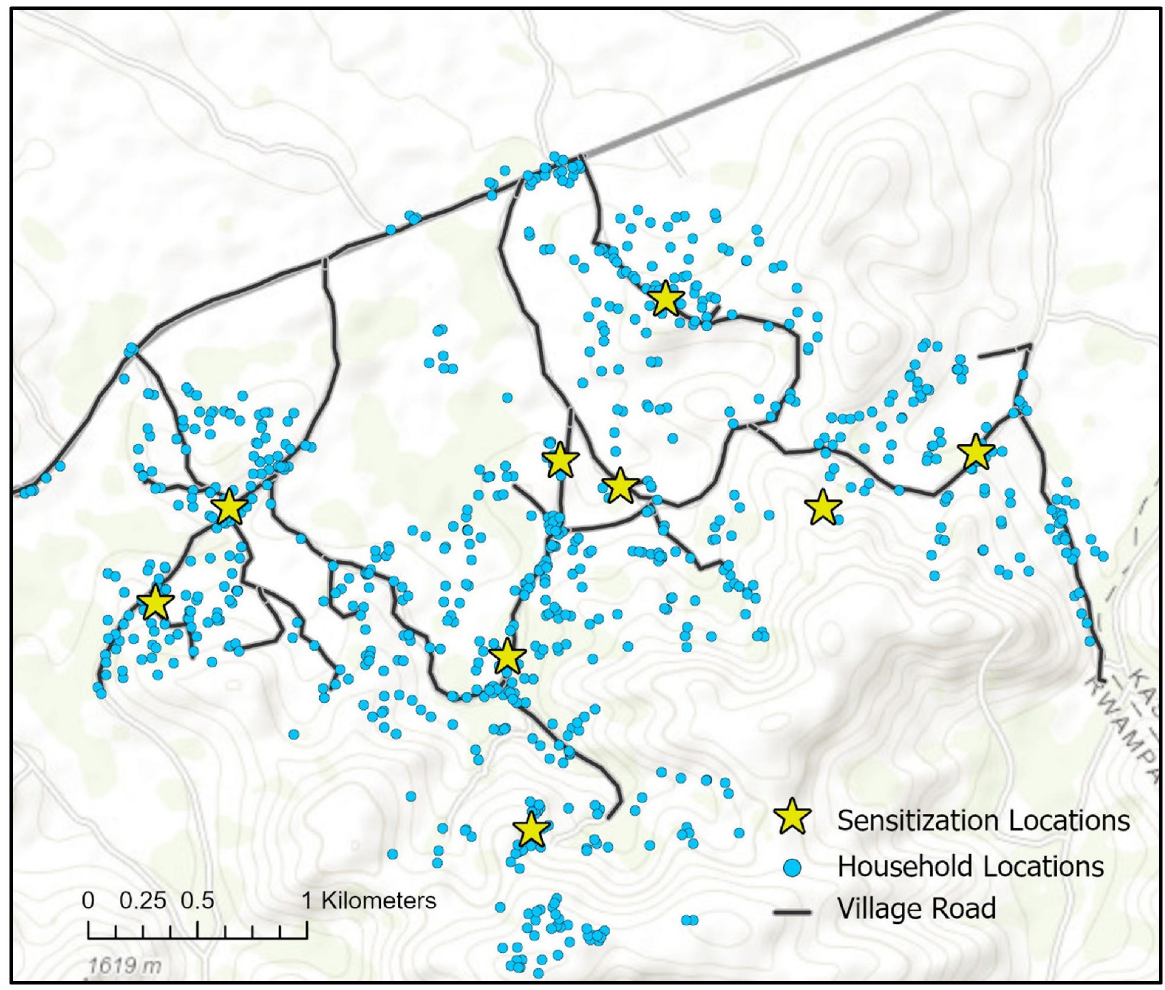
Fig 2. Map of the study parish, community sensitization meeting locations, and participants’ households. Base layer map available at: www.